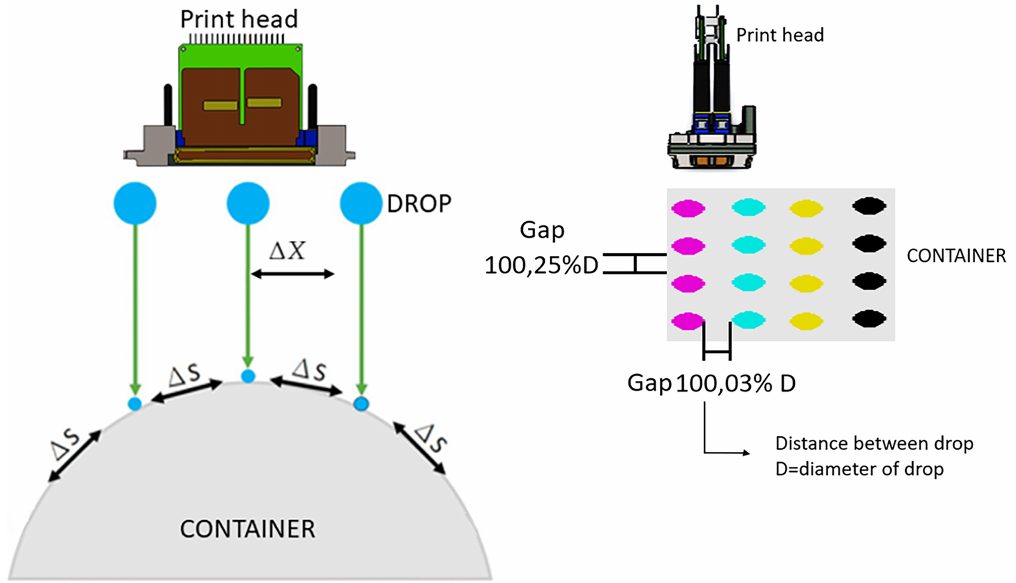
Figure 1. The 2D-3D Distortion and Drop Gap.